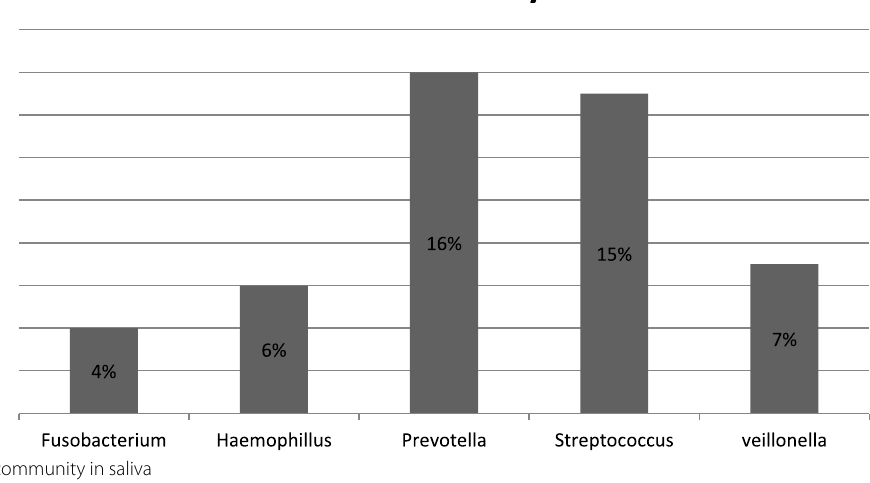
Fig. 3 Microbial community in